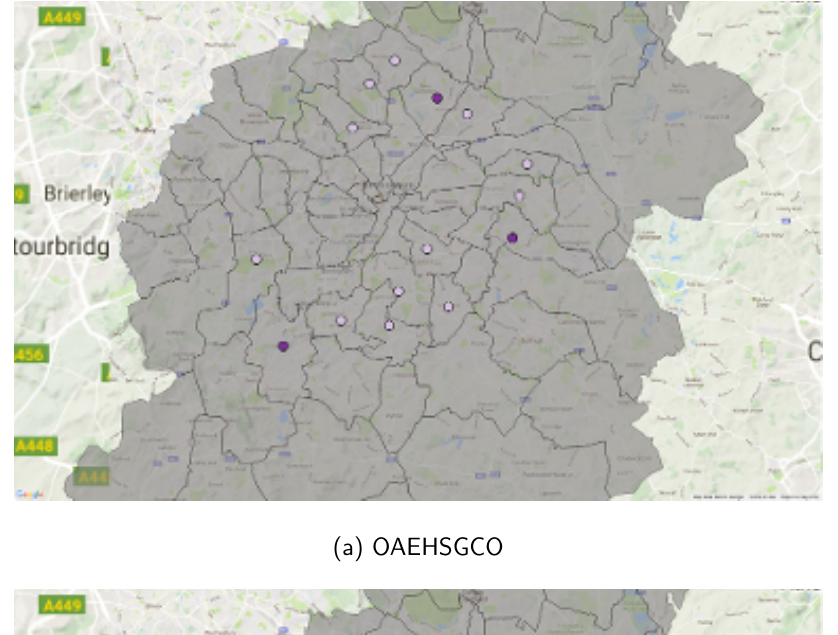
Figure 10: Postcode regions which saw the highest concentration of the three service elements in question between 2010 and 2015: Darker spots, 2 standard deviations above the mean; Lighter spots, 1 standard deviation above the